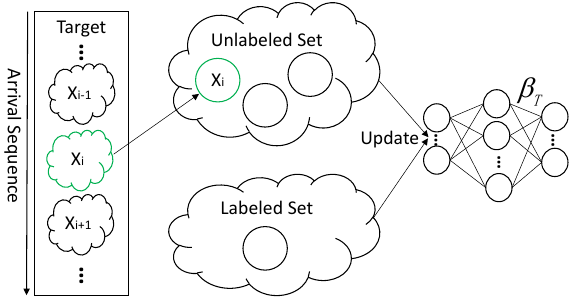
Figure 4. Unlabeled incremental